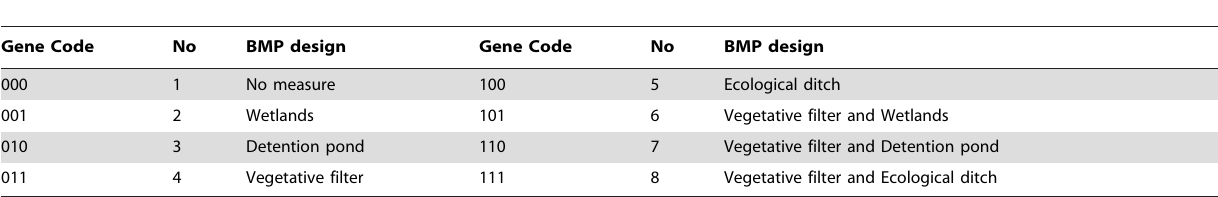
Table 7. The optimization design for the variables coded in the form of genes.